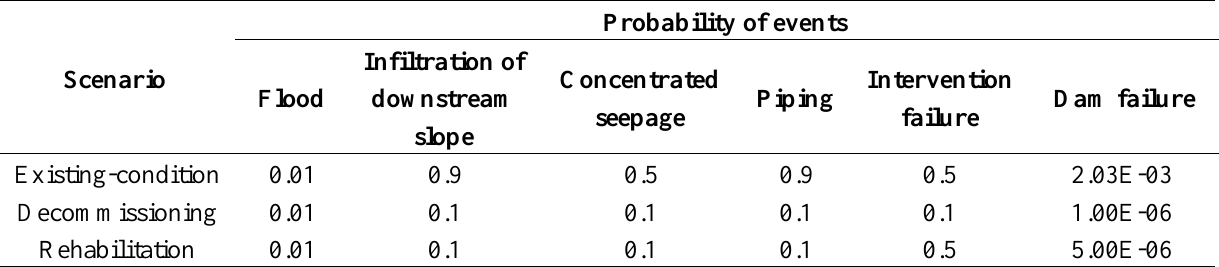
Table 4. Results of event-tree analysis of piping failure.